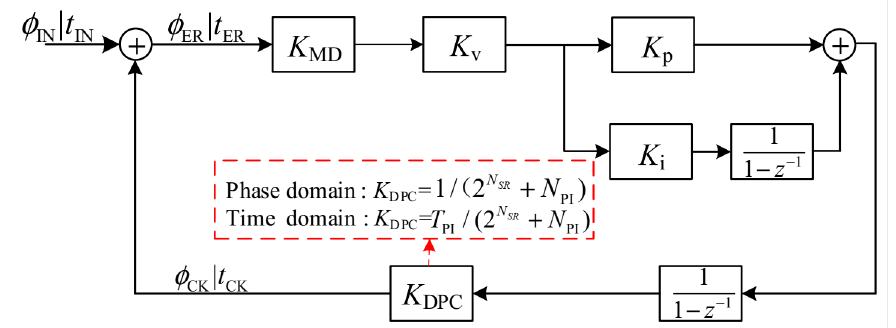
Figure 7. The linearized model of Figure 6.